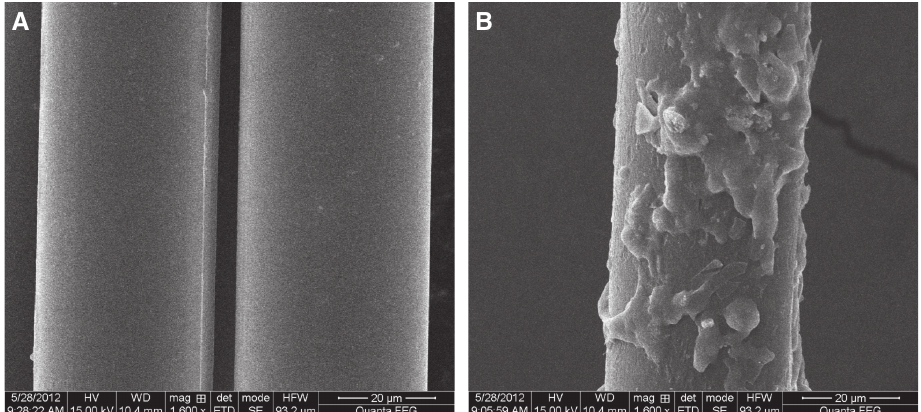
Figure 3 Micromorphology on the surface of alkali-resistant glass fiber. (A) Without surface treatment of fiber. (B) Surface treatment of